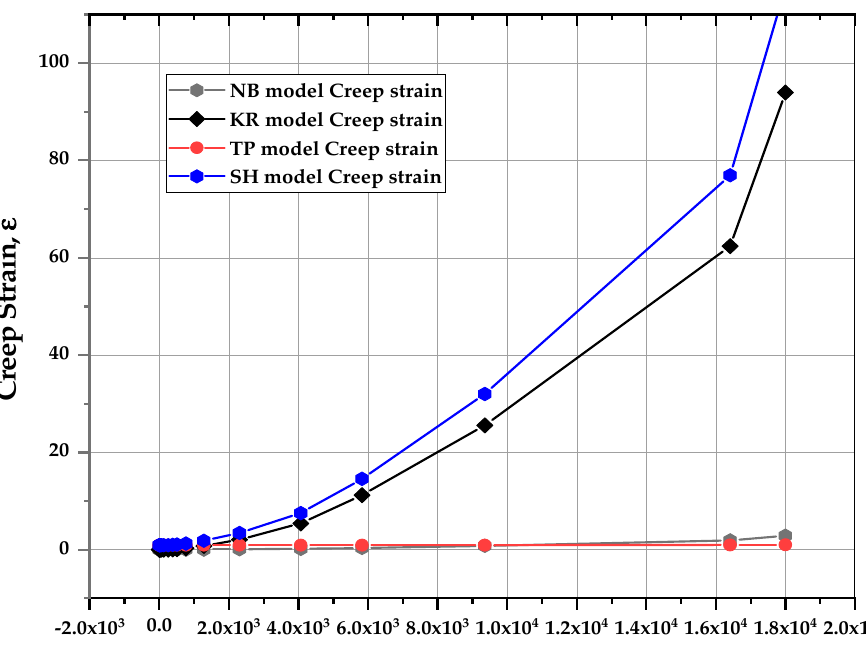
Figure 8. Comparison of creep strain of established models at 720 ◦ C and 60 MPa. The stress-rupture prediction was calibrated into three stress-rupture isotherms to ex- amine the ability of the KR, Theta projection, and sin-h models to forecast stress-rupture [52], whereas the NB and Omega models lacked the ability to predict the stress-rupture curves involving damage evolution parameters. The stress-rupture predictions are shown at 720 ◦ C in Figure 9. When the KR, Theta projection, and sin-h models were compared, it was found that the sin-h models fitted the simulation data best. The KR rupture forecast was linear on a log–log scale, allowing it to represent the region appropriately. Extrapolated rupture predictions can be used to test the physical realism of the KR, Theta, and sin-h rupture